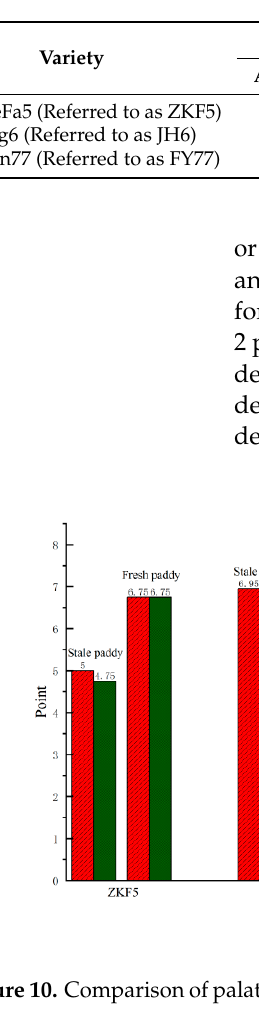
Table 7. Palatability of fresh rice and rice stored for one year.